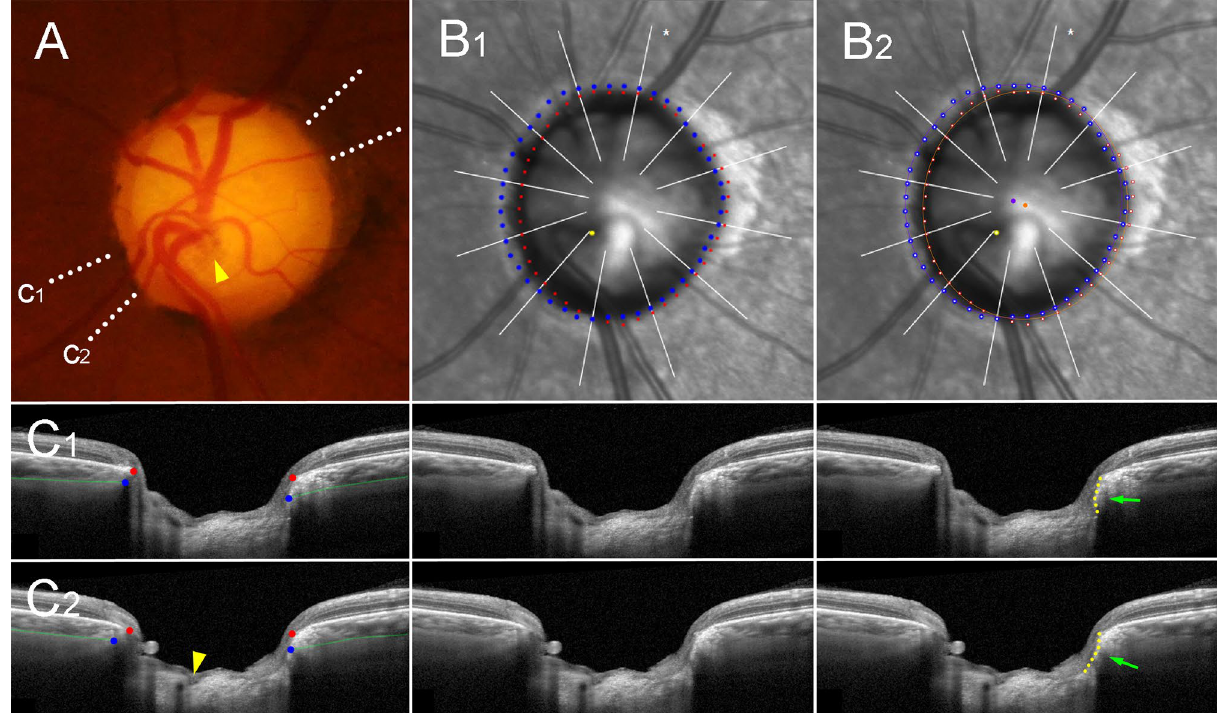
Figure 6. Samplecase of outer-wall shift to inferonasal side (left eye of 58-year-old woman with glaucoma, axial length of 23.94 mm). ( A ) Disc photograph. The arrowhead indicates the location of the central retinal vascular trunk (CRVT). The dotted lines indicate the location of the OCT scan. ( B ) Infrared images. ( B 1 ) Bruch’s membrane opening (BMO, red dots), anterior scleral opening (ASCO, blue dots), and CRVT position (yellow dot) are marked. ( B 2 ) Best-fitted ellipses for BMO (orange ellipse) and ASCO (purple ellipse) are drawn with their centers (orange dot for BMO center, purple dot for ASCO center). ( C ) B-scan OCT images. The left column shows OCT images with demarcation of the BMO margin (red dots) and ASCO margin (blue dots). The green lines indicate the anterior scleral surface. The arrowhead indicates the CRVT. The middle column shows unlabeled OCT images. The right column shows OCT images with demarcation of the peripapillary border tissue of the choroid (PBT-C, upper part of yellow dotted lines) and that of the scleral flange (PBT-S, lower part of yellow dotted lines). The green arrows indicate the ASCO margin, which connects the PBT-C and PBT-S. Please note that the outer-wall shift to the nasal ( C 1 ) and inferior ( C 2 ) sides is more severe in the more-outer layer (the lamina cribrosa [LC] with CRVT) than in the superficial layer (ASCO), and is presented as an abrupt change between the PBT-C and the PBT-S. This could explain why the CRVT alone is deviated while the ASCO is immediately next to the BMO in this